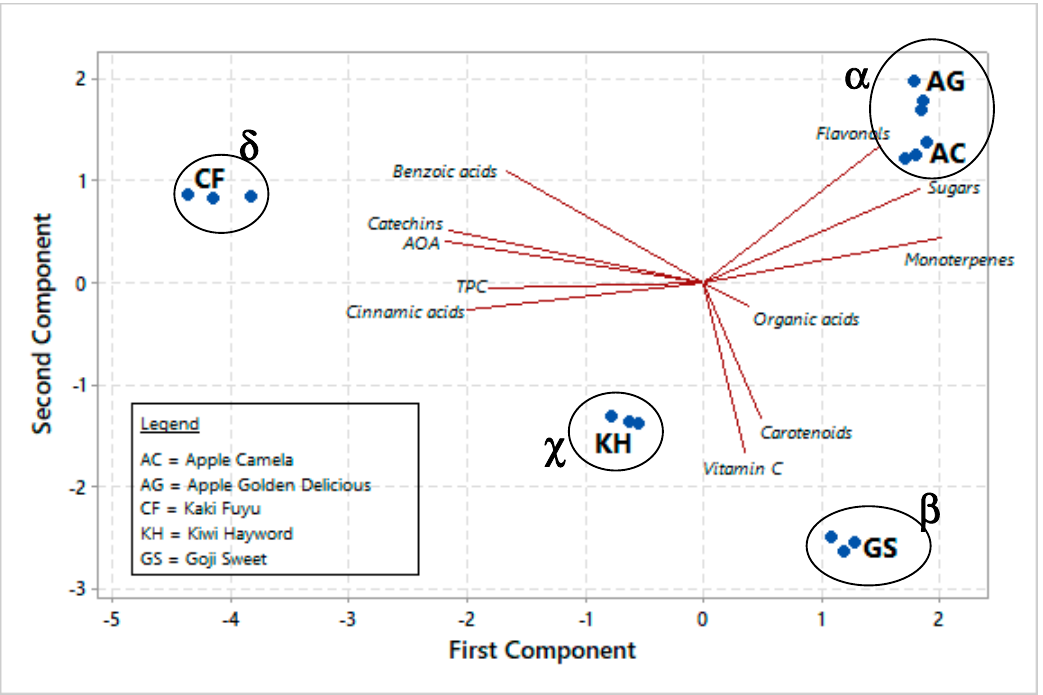
Figure 3. PCA biplot of dried fruit products (three replications for each sample). The ellipses only define the category position in the PCA biplot with no statistical meaning. Biplot shows correlation among nutri—nutraceutical properties and PCs.